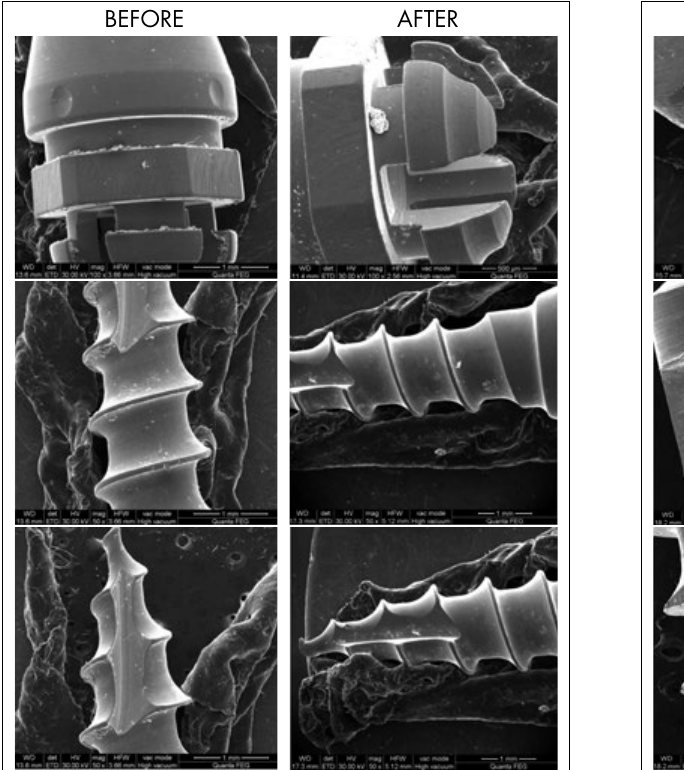
Figure 6. Back scattered SEM images of Group 4